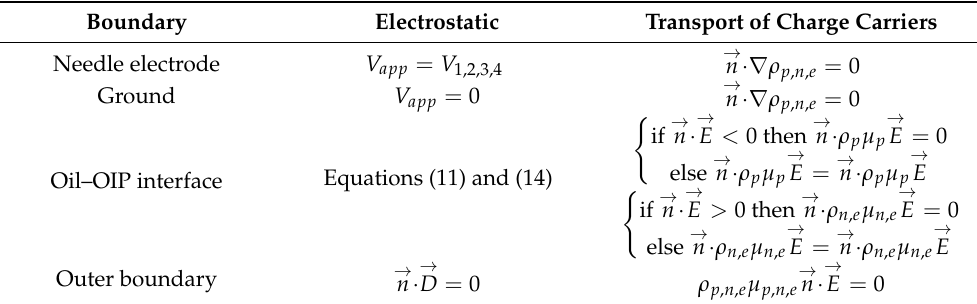
Table 2. Boundary conditions.